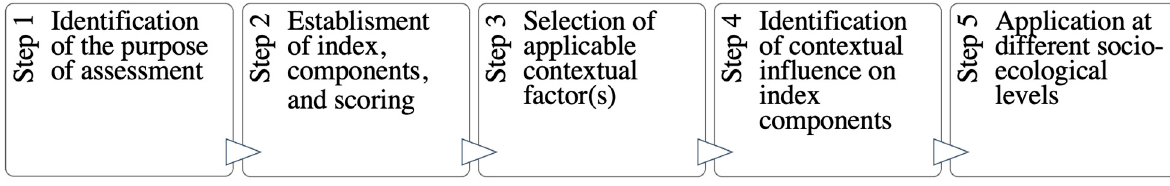
Figure 1. Holistic Dietary Quality Assessment Process.